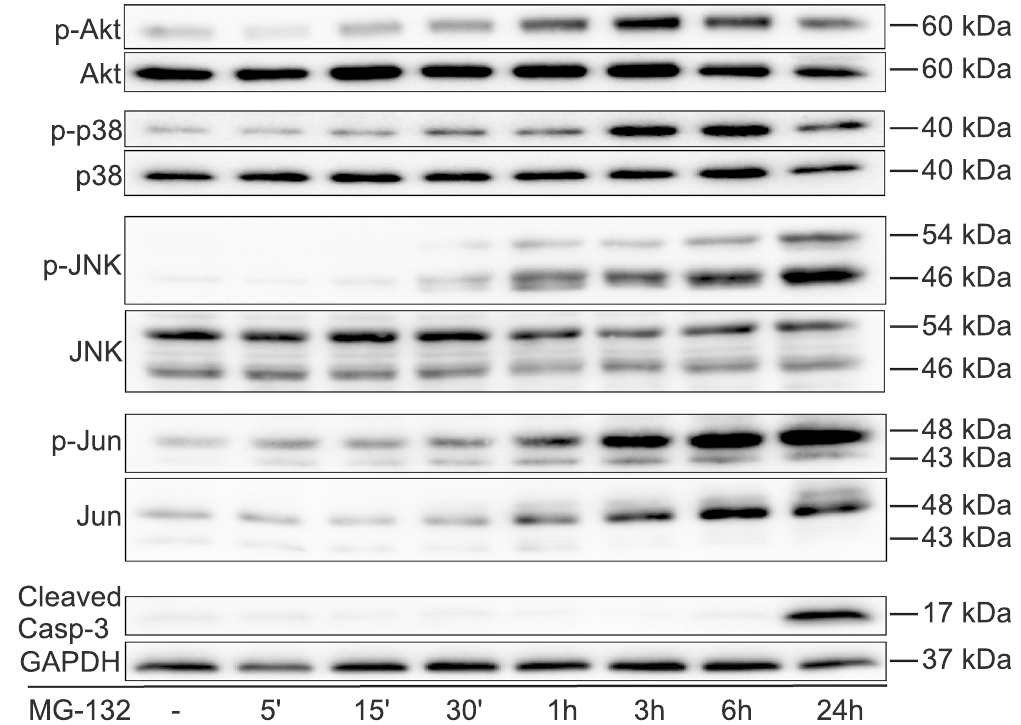
Figure 2. Time kinetics of MG-132-induced Akt, p38, JNK, c-Jun phosphorylation and caspase-3 cleavage. Representative Western blots show the phosphorylation changes of Akt, p38, JNK and c-Jun or the activating cleavage of caspase-3 after 0, 5, 15, 30 min or 1, 3, 6 and 24 h of MG-132 (2.5 µM) treatment. Blots (except for caspase-3) were first probed with phospho-specific antibodies (upper panels), followed by stripping and re-probing with the antibodies specific for the non-phosphorylated forms of the proteins (lower panels). The GAPDH signal was loading reference for cleaved caspase-3. All blots were cropped, original membrane images are shown in Supplementary Fig. 4. All experiments were repeated with similar